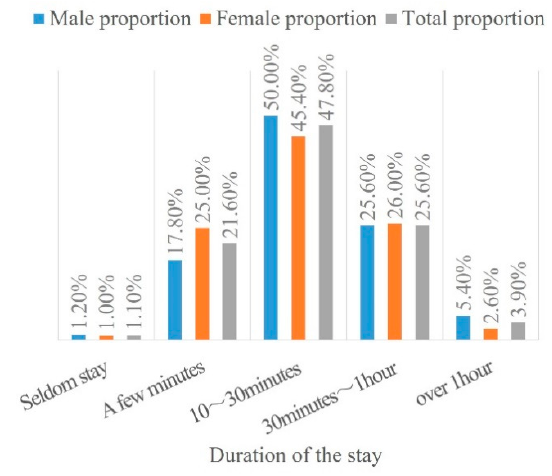
Figure 9. Staying time preference.